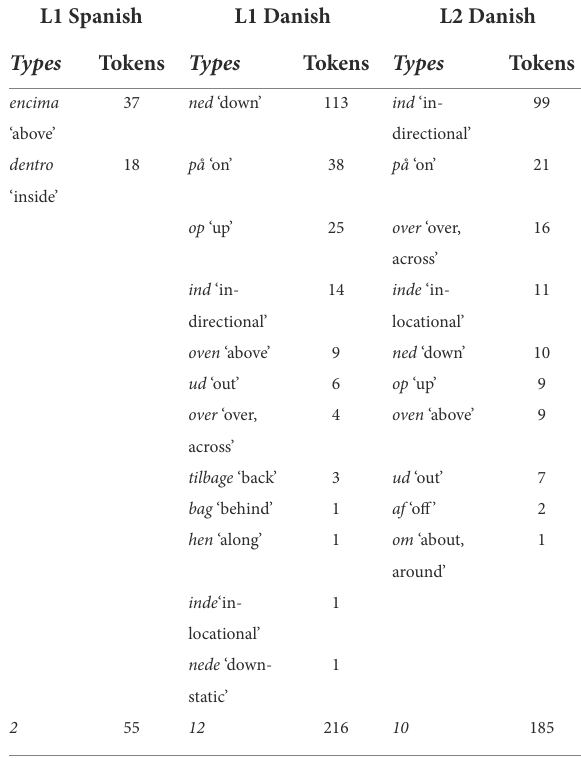
TABLE 6b Multinomial logistic regressions with PC #3 as baseline (L2-Danish baseline).